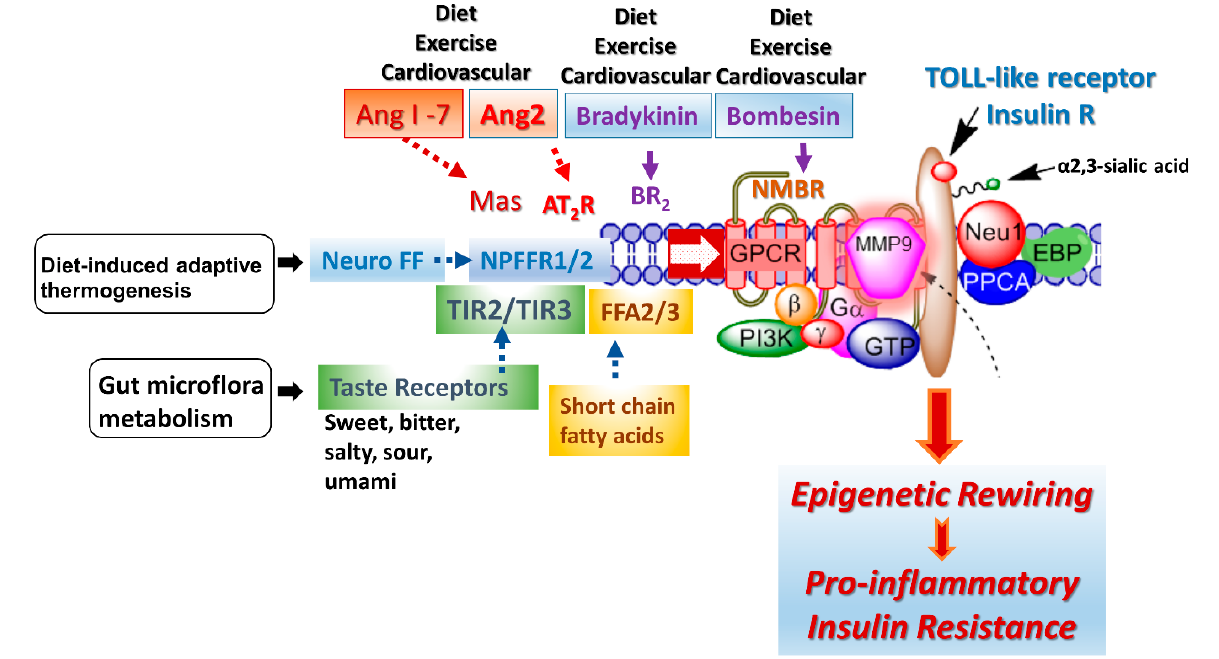
Figure 4. The GPCR receptors, bradykinin (BR2) and angiotensin II receptor type I (AT2R), are tethered with neuromedin B (NMBR), insulin receptor (IR β ) or TOLL ‐ like receptor (TLR), and Neu1 in naïve (unstimulated) and stimulated IR expressing HTC ‐ IR cells (adapted from Haxho et al. (2018) [51] ) and TLR expressing live macrophage cell lines and primary macrophage cells [50]. Here, the link regulating the interaction of these molecules and their signaling mechanism(s) on the cell surface reveals a novel biased GPCR signaling process in inducing the IR β and TLR transactivation signaling, with subsequent activation of Neu1 sialidase and the modification of the receptor glycosylation. Notes: GPCR agonists can potentiate a biased neuromedin B (NMBR) ‐ IR signaling via MMP ‐ 9 activation to induce Neu1 sialidase. Activated MMP ‐ 9 removes the elastin ‐ binding protein (EBP) as part of β‐ galactosidase/Neu1 and protective protein cathepsin A (PPCA). Activated Neu1 in turn hydrolyzes α‐ 2,3 sialyl residues of IR β at the ectodomain to remove steric hindrance, facilitate IR β subunits association and activate IR tyrosine kinase. Activated phospho ‐ IR β subunits phosphorylate insulin receptor substrate ‐ 1pIRS1, which initiates intracellular insulin signaling via the Ras ‐ MAPK and the PI3K ‐ Akt pathway, promoting epigenetic rewiring and insulin resistance.